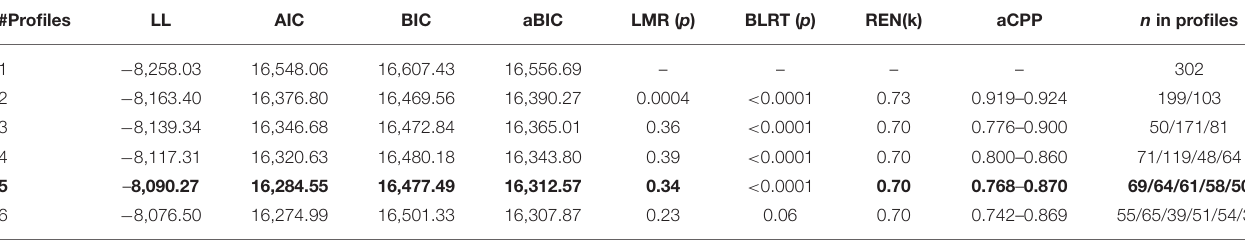
TABLE 3 | Model fit statistics and classification quality of the latent